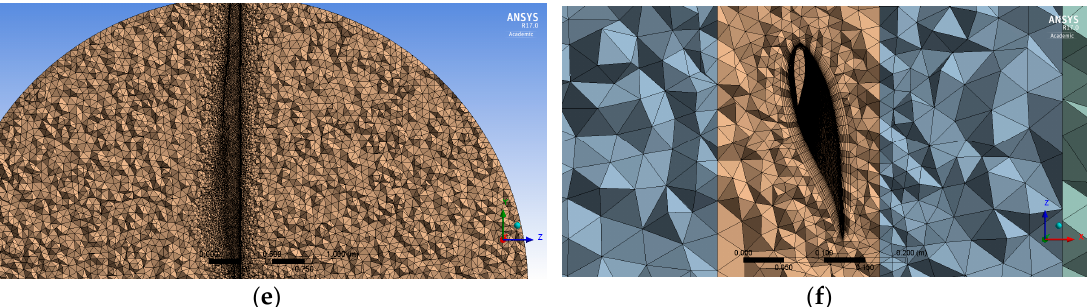
Figure 4. Mesh of the Computational Domain. ( a ) Computational domain; ( b ) Rotational disc; ( c ) Front view: sectional plane showing details of the rotational central disc and the sphere of influence; ( d ) Lateral view: sectional plane showing details of the sphere of influence and the rectangular near wake region; ( e ) Sectional plane showing the mesh close to the blade surface; ( f ) Sectional plane showing inflation layers close to the blade surface.